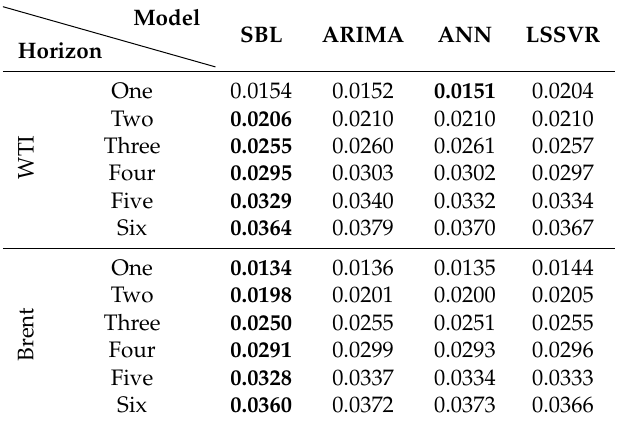
Table 1. The MAPE values by different single models on WTI and Brent crude oil prices.